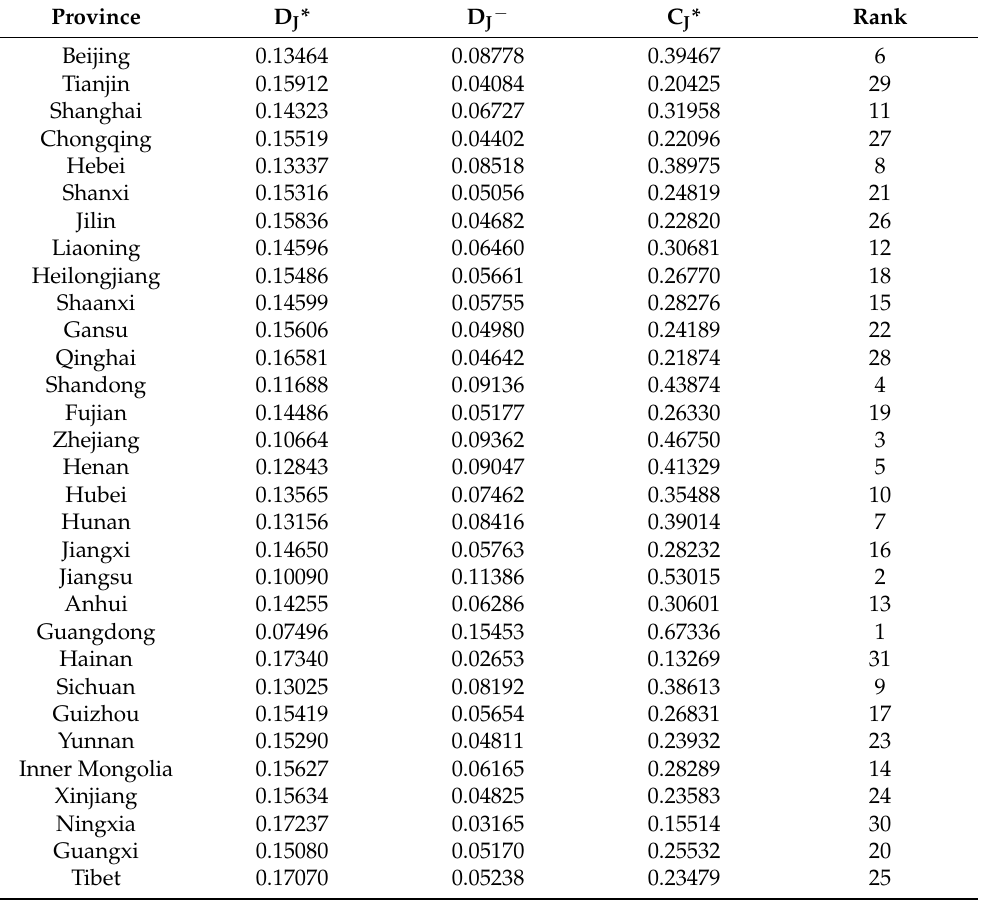
Table A10. The relative distance from the positive ideal solution